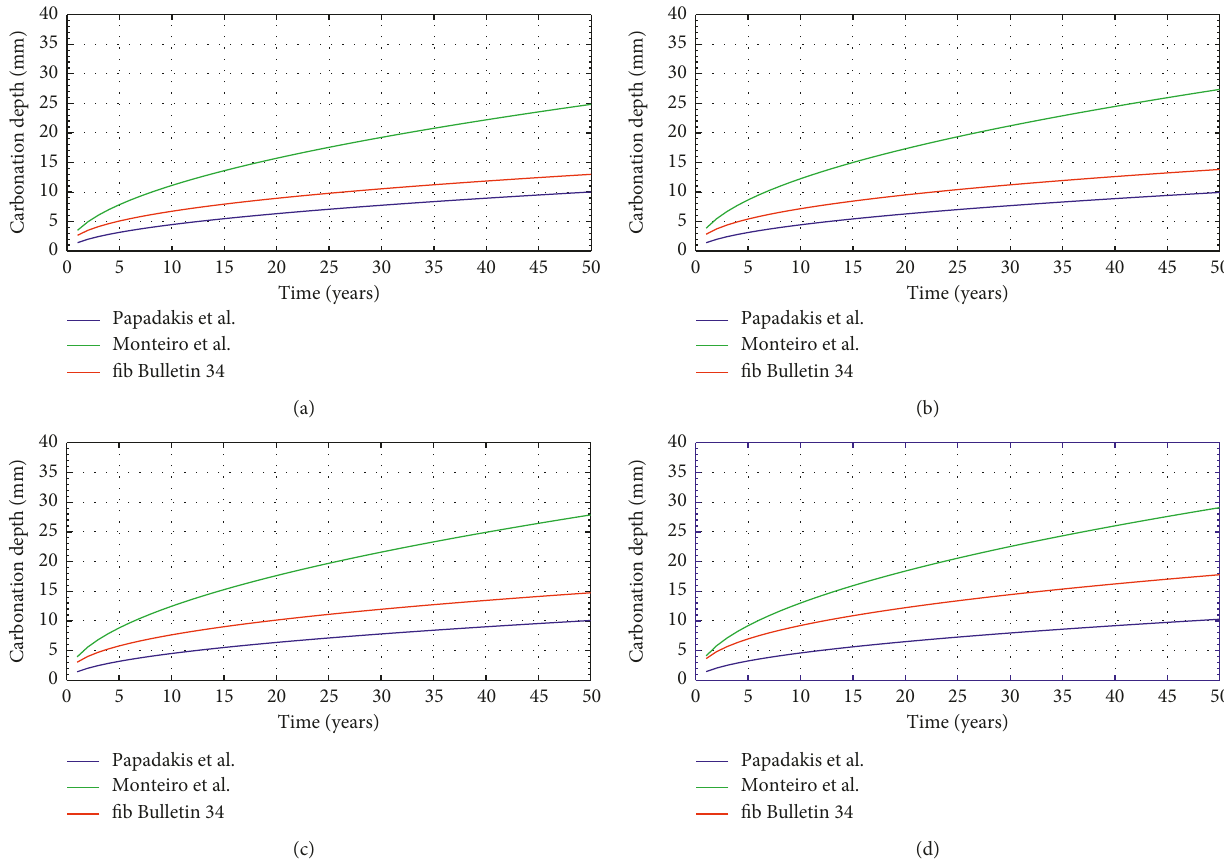
Figure 7: Comparison between models’ prediction of carbonation depth versus service life: XC3 exposure class: w/c � 0.55. (a) R � 0%, (b) R � 20%, (c) R � 50%, (d) R �